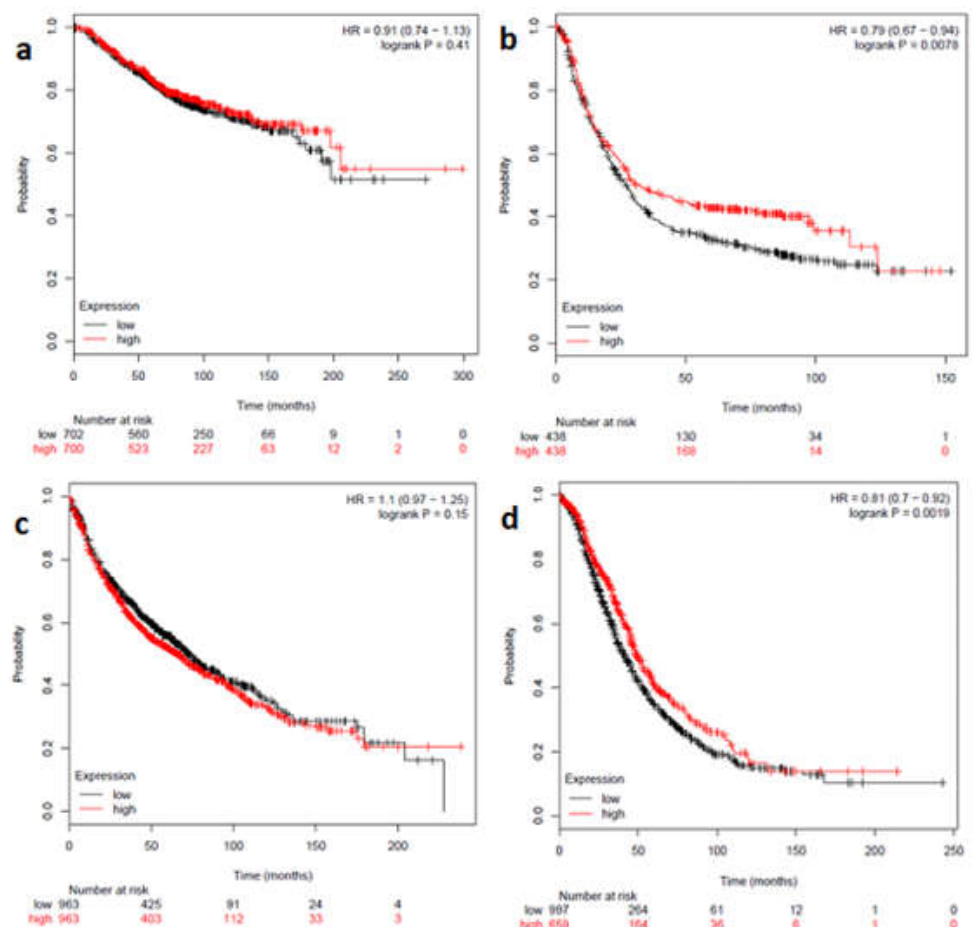
Fig. 6. Kaplan-Meier plotter was utilized to identify the association of deregulation of the CXCL10 gene with the overall survival of patients with different cancer types. a. Breast cancer plot. b. Gastric cancer plot. c. Lung cancer plot. d. Ovarian cancer plot. (Color should be